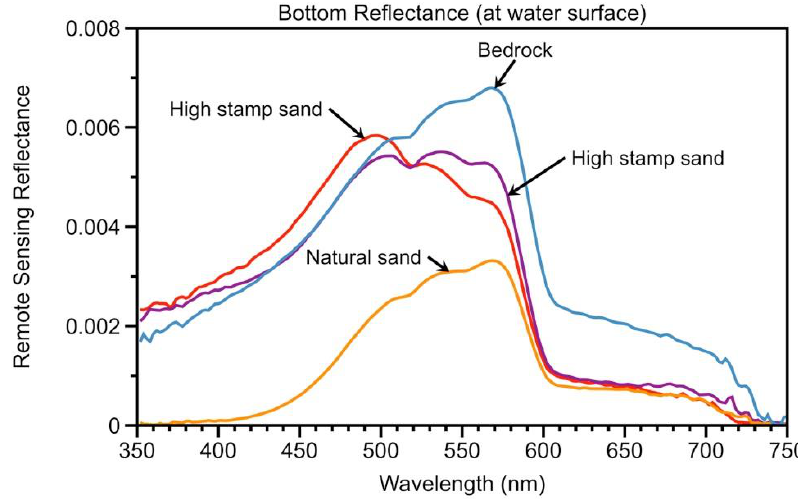
Figure 17. Deep-water ( > 8 m) Bottom Reflectance Spectra. Notice how spectra show severe attenuation at longer and shorter wavelengths. Moreover, blue-green peaks of reflectance are highly variable, differentially influenced by light scattering properties in the water column, plankton, suspended matter and perhaps DOC. At some sites, the natural sand shows less bottom reflectance than stamp sand.